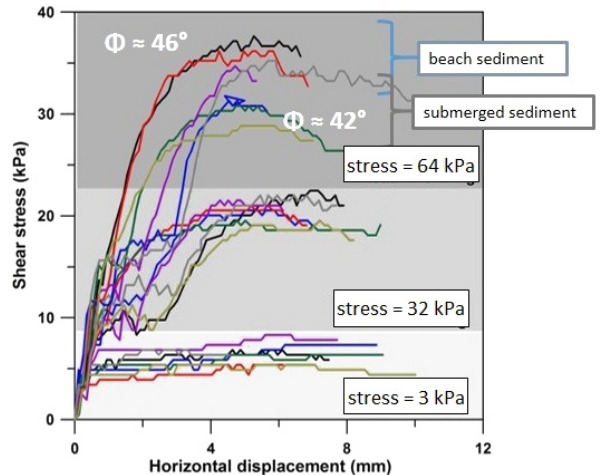
Figure 5. Horizontal displacement versus shear stress of samples with a grain size d ≤ 2mm measured in the small direct shear box. The different stages of normal stress are indicated by different gray shades. At the highest loading stage, a difference in the shear stress path between the beach-face sediments and samples from perma- nently submerged sites can be observed, leading to differences in the internal angle of friction φ .